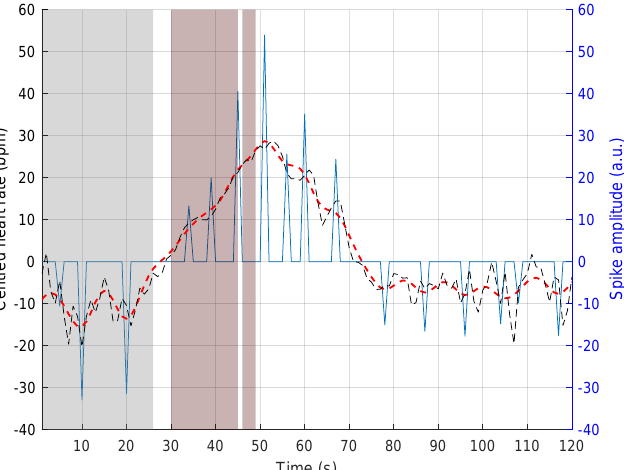
Figure 5. Effect of a movement on the sparse decomposition; sparse model (blue spikes), high-pass filtered heart rate (plain black line), and reconstructed heart rate (dashed red line); apnoea highlighted by the greyed areas and movement highlighted by the red